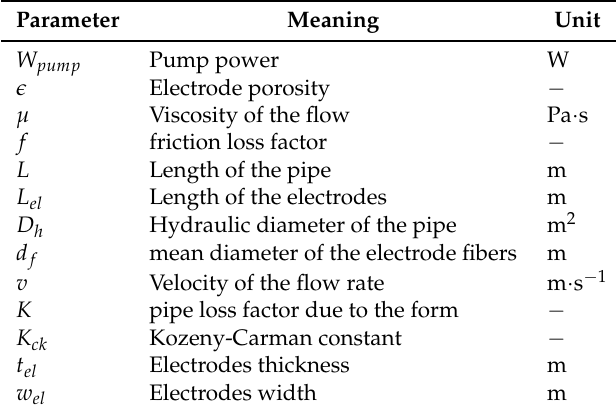
Table 10. Parameters of the hydraulic